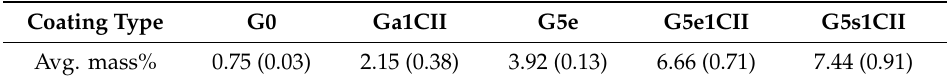
Mass percent (%) of coating for select formulations (parentheses indicate one standard